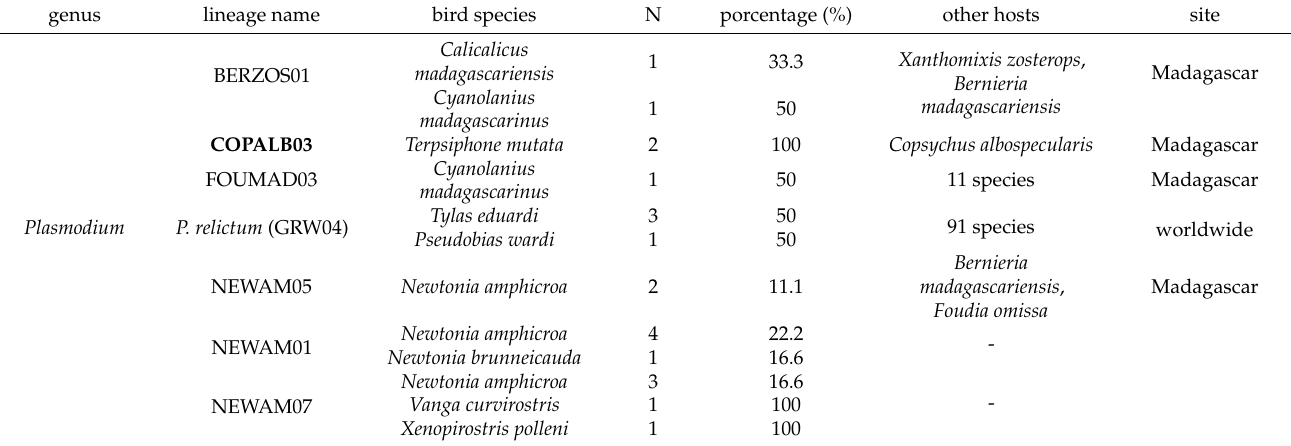
Table 2. Haemosporidian lineages found in our study. Isolation source is given as bird species name and total number of detections within the species (N). Furthermore, the percentage (%) of the lineage in the absolute infected samples of the bird species with regard to the parasite genus is also listed. Data of other bird hosts and sites of those hosts were drawn from the MalAvi database (as of July 2022). “-“ indicates that no other host has been reported. Bold text indicates lineages for which gametocytes were detected in blood smears.